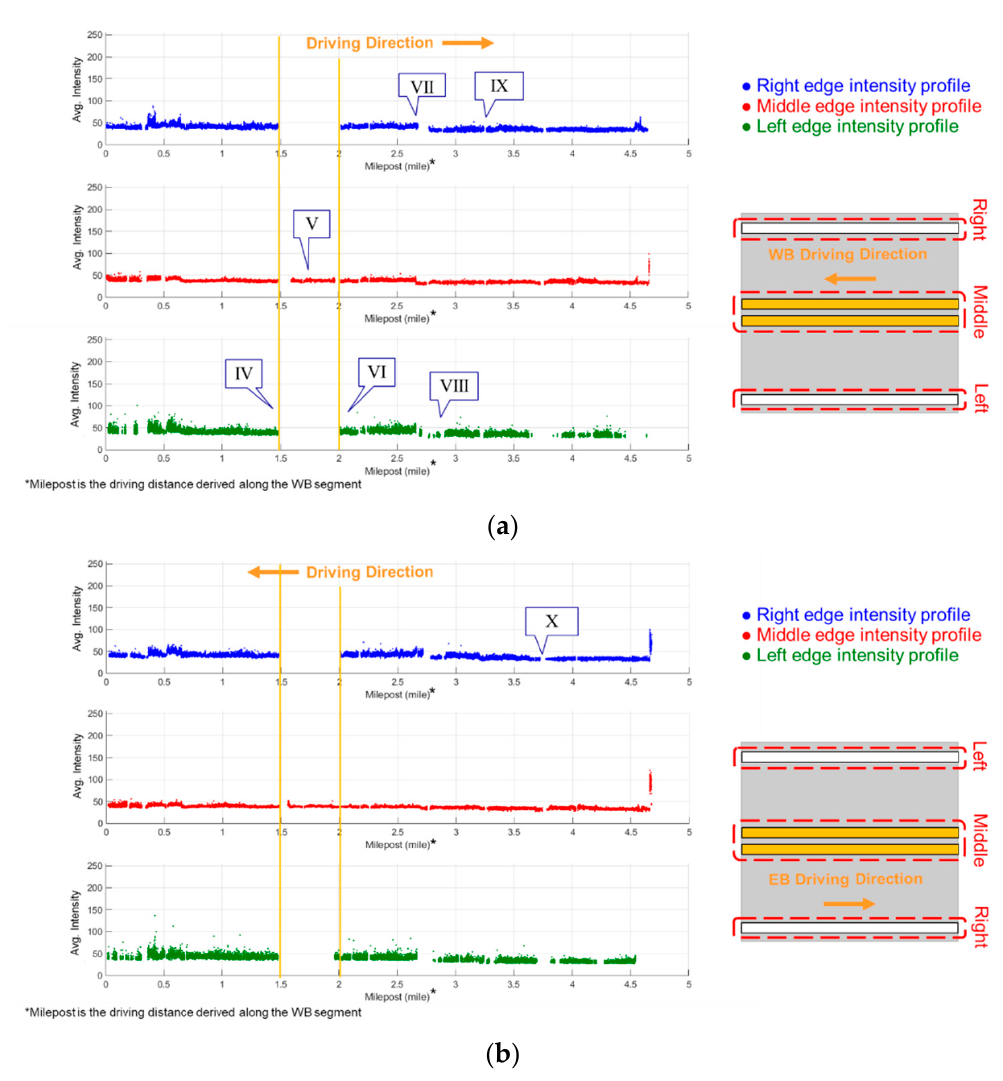
Figure 25. Intensity profiles (right, middle, and left edges) with similar changes (highlighted by yellow lines) for ( a ) WB and ( b ) EB segments.